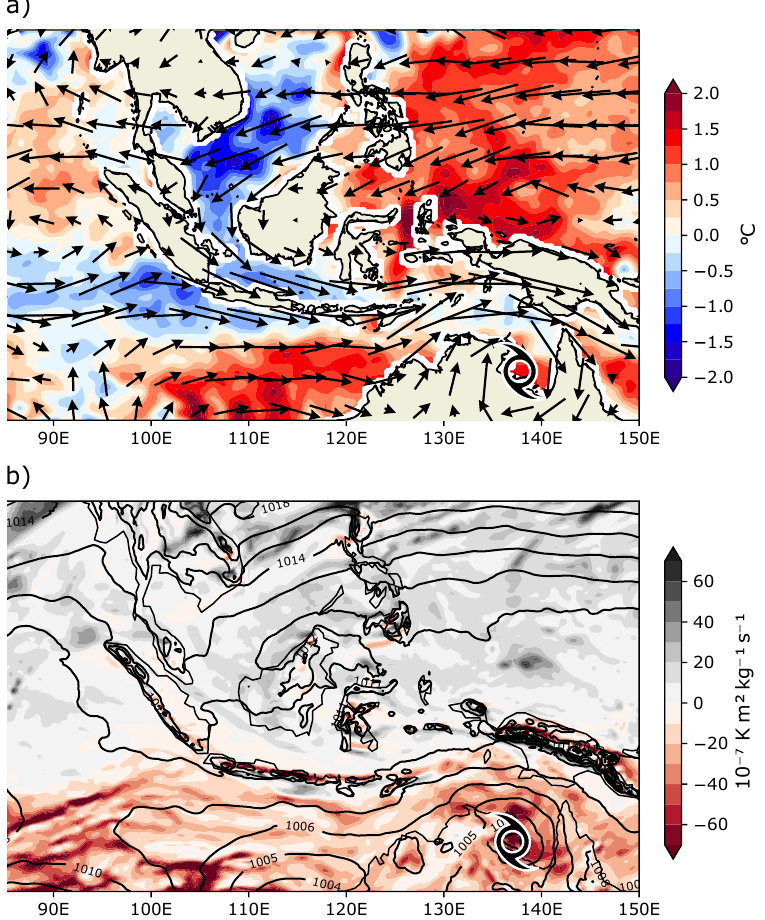
Figure 9. ( a ) SST anomalies superimposed with 850 hPa horizontal wind anomalies (vectors) averaged from 4 to 6 February 2021. ( b ) 850 hPa potential vorticity (PV) anomalies superimposed with mean sea level pressure anomalies averaged from 4 to 6 February